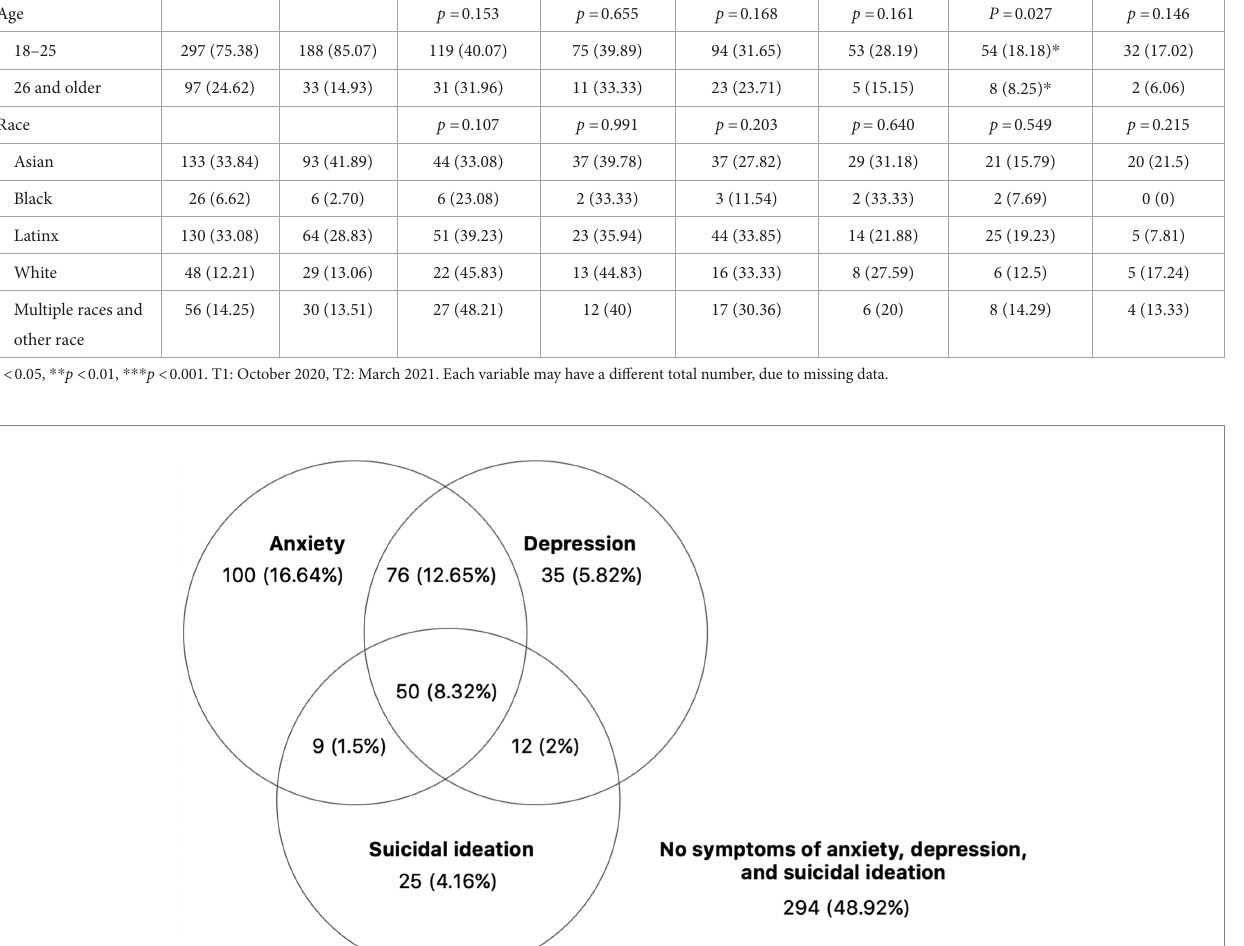
with 96.05% reporting that this was due fully or partially to the COVID-19 pandemic (Table 2). Participants reported feeling on top of things for several days (43.40%), more than half the days (21.23%), and nearly every day (8.49%). Student researchers also inquired about various distressing experiences that participants or someone in their